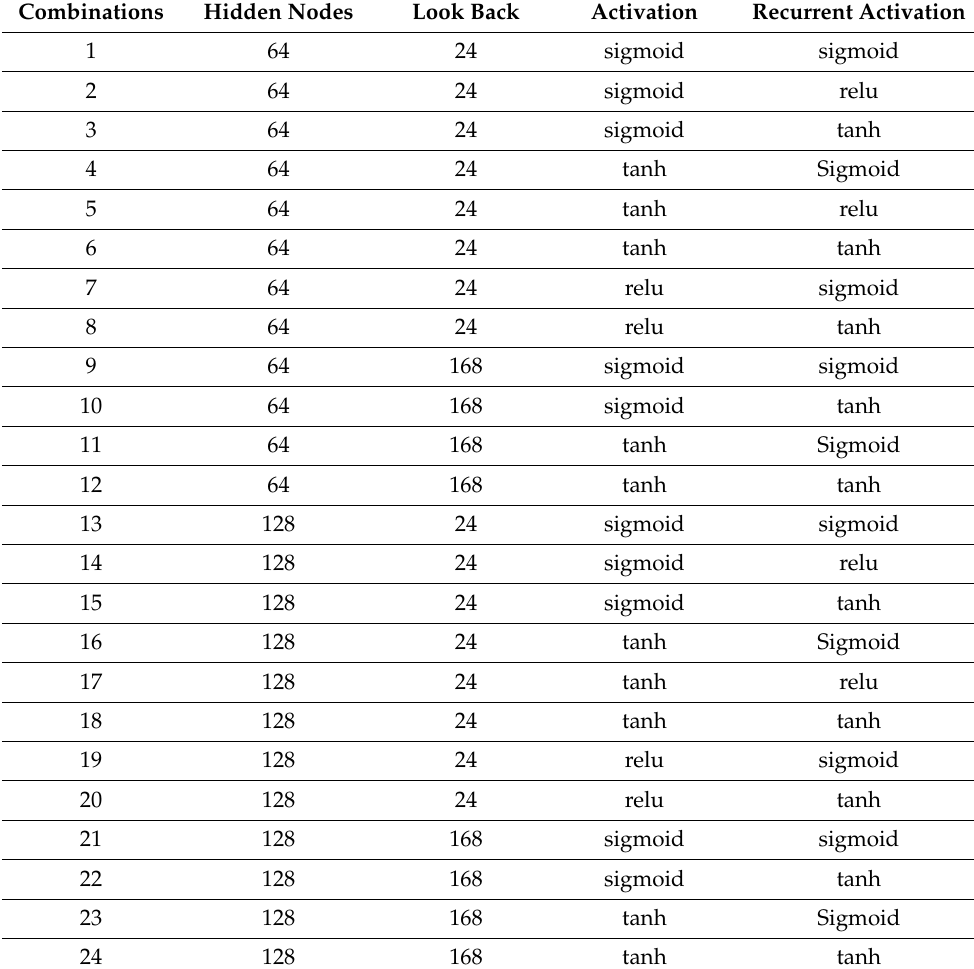
Table 5. Trial of parameter